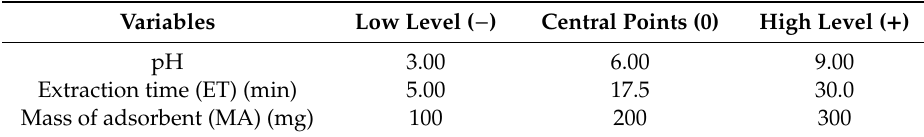
Table 1. Variables and levels used in Box–Behnken